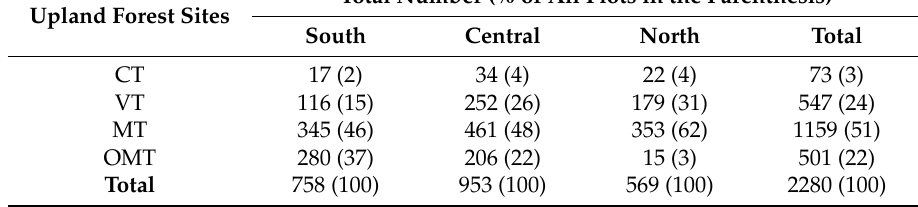
Table 4. Number (%) of sample plots of the National Forest Inventory (NFI11) on different upland forest sites for southern (old Forestry Centre units 1–6), central (7–10), and northern (11–13) boreal regions. The upland site types included poor (dry heath, Calluna type, CT), quite poor (dryish heath, Vaccinium type, VT), medium (fresh heath, Myrtillus type, MT), and rich (grove-like heath, Oxalis-Myrtillus type, OMaT) sites. Total Number (% of All Plots in the Parenthesis) Upland Forest Sites South Central North Total CT 17 (2) 34